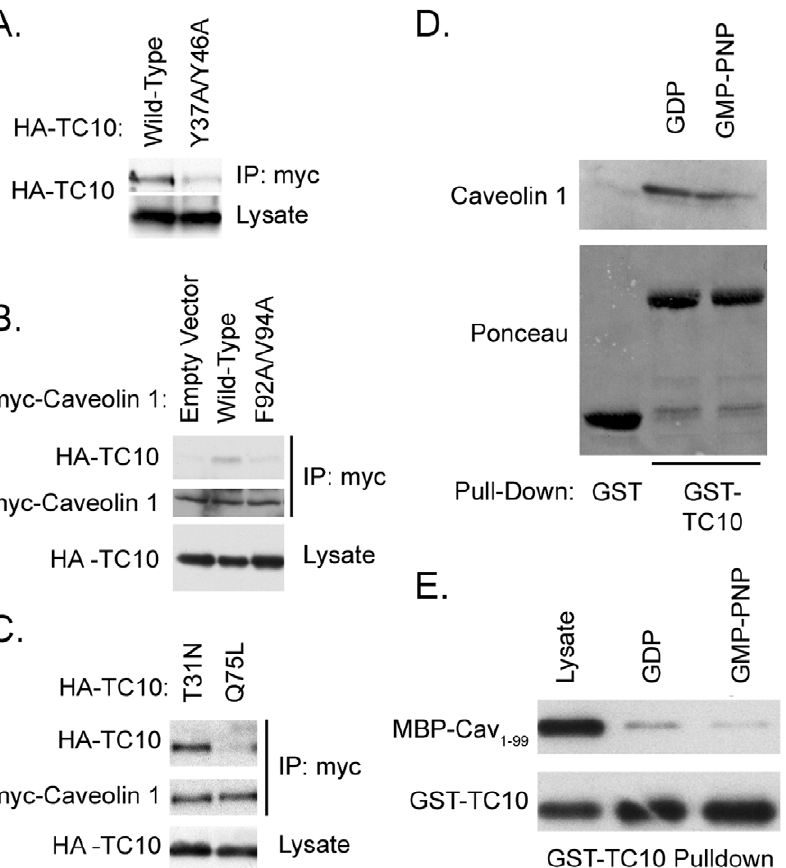
Figure 4. TC10 and Caveolin interact in a GDP-dependent manner. A) COS-1 cells were transfected with 100 ng of pKMyc-Caveolin 1 and 100 ng of pKH3-TC10 wild-type or pKH3-TC10 Y37A/Y46A. Lysates were immunoprecipitated with anti-myc antibodies and blotted for the HA epitope. B) COS-1 cells were transfected with pKMyc-Caveolin 1 wild-type or F92A/V94A alleles along with HA-TC10. Cells were lysed, and lysates were immunoprecipitated with anti-myc antibodies and blotted with either anti-myc or anti-HA antibodies. C) COS-1 cells were transfected with pKMyc-Caveolin 1 and pKH3-TC10 T31N or Q75L mutants. Lysates were immunoprecipitated with myc antibodies and blotted with either anti-myc or anti-HA. D) GST-TC10 bound to glutathione-agarose beads was preincubated with nucleotides as indicated, then used to precipitate proteins from a 3T3-L1 adipocyte lysate. Eluted fractions were probed with either anti-Caveolin antibodies or stained with Ponceau S. E) Purified MBP-Caveolin 1 (1–99) and GST-TC10 were incubated with the indicated nucleotide overnight at 4 u C. Complexes were then purified by adding glutathione agarose for 1